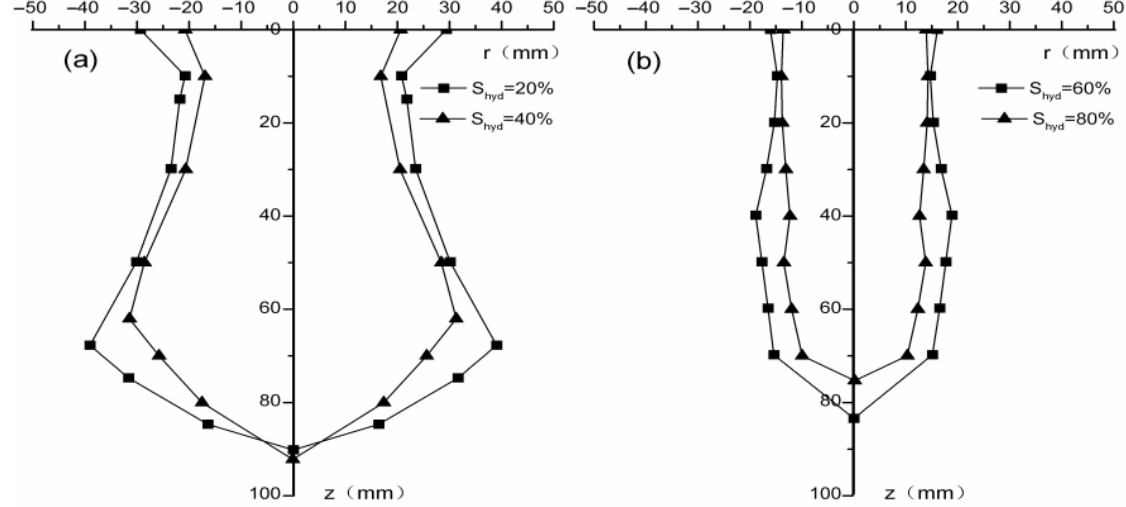
Figure 10. Scatter plots of the erosion holes section at different hydrate saturation. ( a ) 20–40%; ( b )